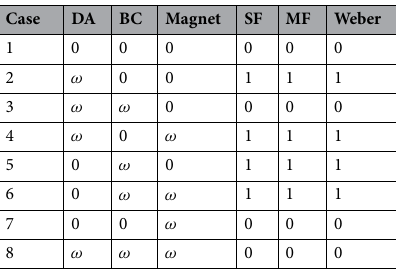
Table 1. Predicted EMF in 8 possible cases for three different theoretical interpretations. BC and DA relate to the parts of the measurement circuit that can move, where BC is the closing wire and DA the disc, as illustrated in Fig.